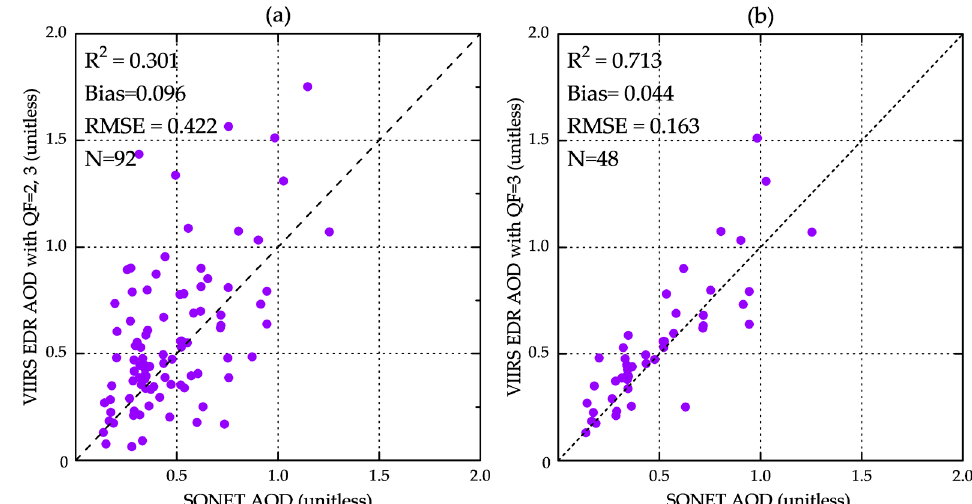
Figure 2. Scatter plots of Visible Infrared Imaging Radiometer Suite (VIIRS) aerosol optical depth (AOD) at 550 nm vs. SONET AOD at 500 nm for quality flag (QF) = 2 or 3 ( a ) and for QF = 3 ( b ) at the Xi’an site. The black dashed line is the identity line. Statistics in the upper left corner indicate coefficient of determination ( R 2 ), bias, root-mean-squared prediction error (RMSE), and number of data points ( N ).